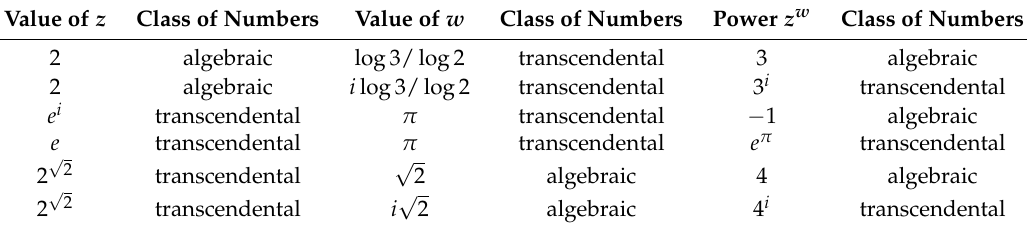
Table 1. Arithmetic possibilities for z w when either z or w is